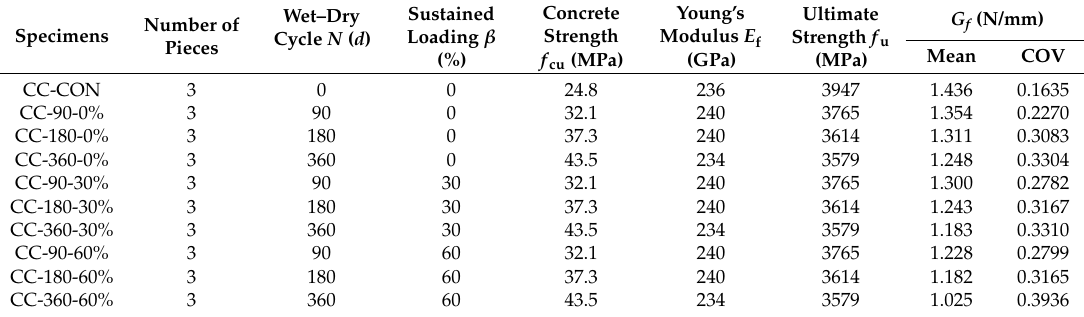
Table 1. Parameters of the specimens.